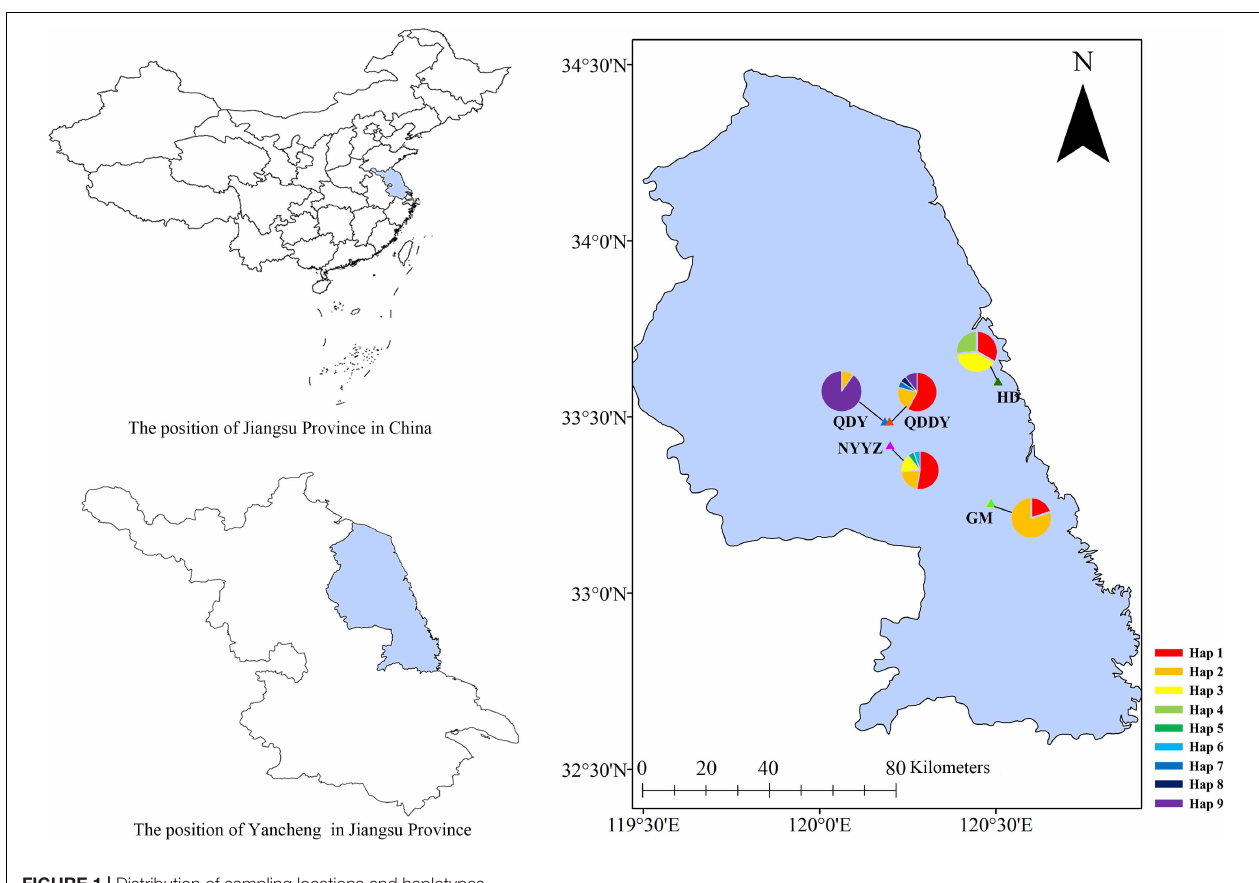
FIGURE 1 | Distribution of sampling locations and haplotypes.